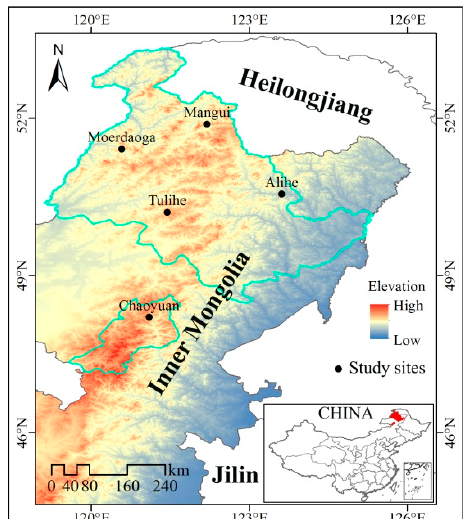
Figure 1. The location of the study area and sampling sites in the western Daxing’anling Mountains, northeastern China.